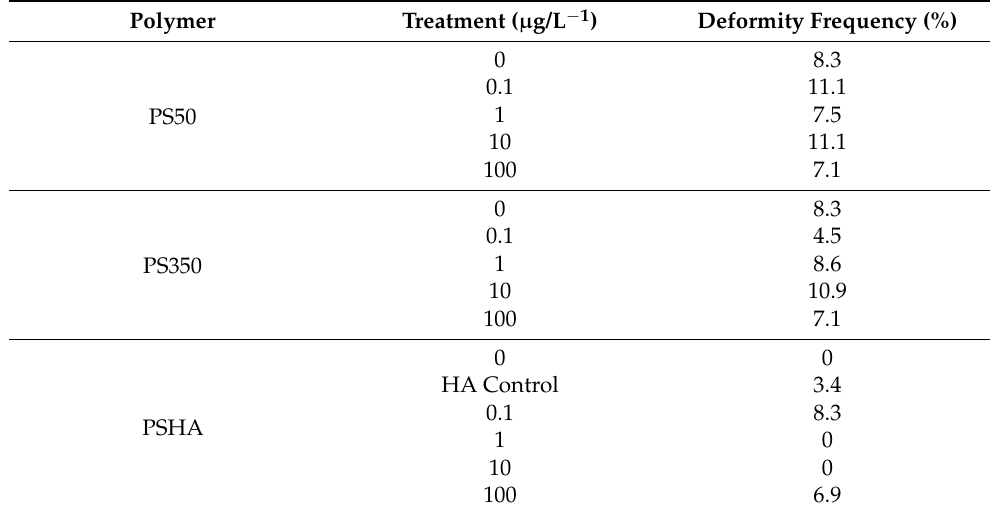
Table 4. Teratogenesis on C. riparius larvae exposed to PS, PS350, and